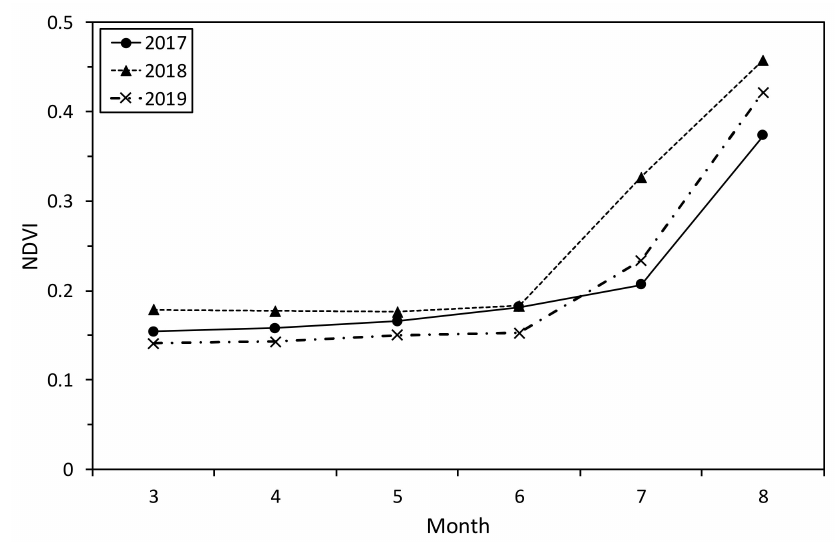
Figure 7. Monthly NDVI in Bayan-Unjuul from 2017 to 2019.